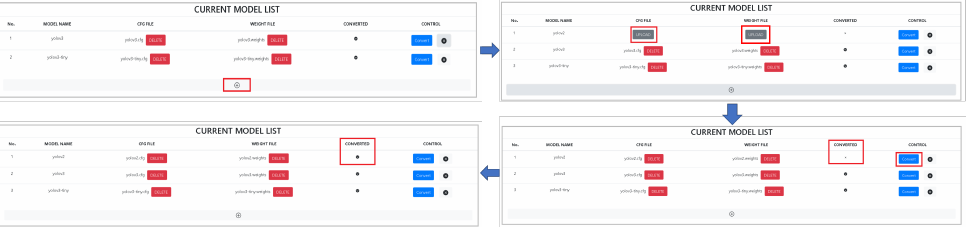
Figure 7. File manager inferface and converting procedure of a specific neural network model.